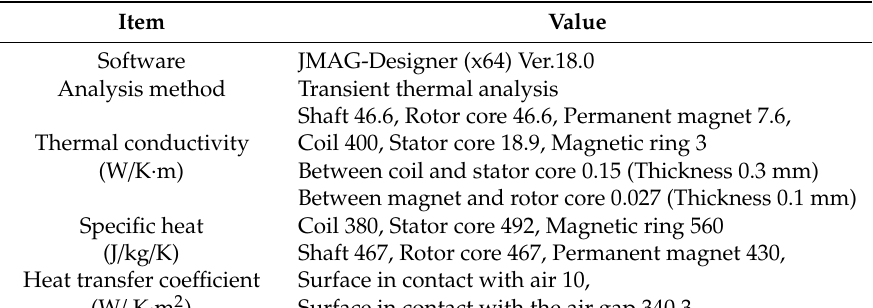
Table 4. Thermal characteristic parameters.